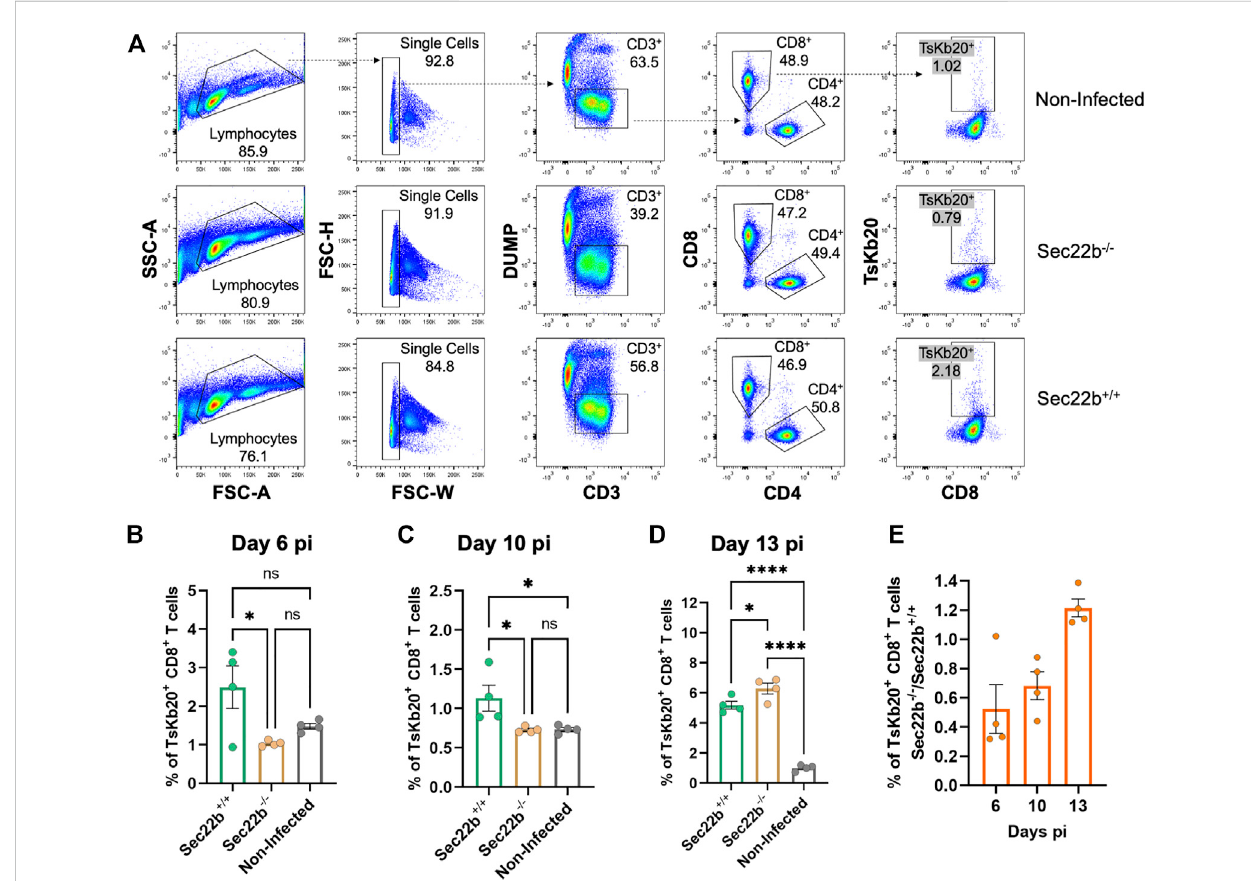
FIGURE 3 Analysis of the speci fi c TsKb20-CD8 + T cells response in lymph nodes. (A) Gating strategy used to analyze cells derived from lymph nodes at day 10pi.Aswithsplenocytes,CD3 + cellswereselected,excludingdeadcells,Blymphocytes,andmyeloidcellswithaDUMPchannel.CD8 + Tcellswerethen determined (as positive cells for the CD8 marker) and TsKb20-CD8 + T cells were determined as the tetramer positive population. Analysis of the speci fi c TsKb20-CD8 + T cells (%) in lymph nodes at day 6 p. i. (B) ( p-values : Sec22b +/+ vs. Sec22b − / − 0.0263, Non-Infected vs. Sec22b +/+ 0.1194, Non- Infected vs. Sec22b − / − 0.6087; day 10 p. i.) (C) ( p-values : Sec22b +/+ vs. Sec22b − / − 0.0377, Non-Infected vs. Sec22b +/+ 0.0399, Non-Infected vs. Sec22b − / − 0.9993) and day 13 p. i. (D) ( p-values : Sec22b +/+ vs. Sec22b − / − 0.0411, Non-Infected vs. Sec22b +/+ < 0.0001, Non-Infected vs. Sec22b − / − < 0.0001). The analysis was performed using One way ANOVA with Tukey ’ s multiple comparison test, N = 4 (E) Ratio of the percentage of speci fi c TsKb20-CD8 + T cells found in Sec22b − / − mice over the percentage of TsKb20-CD8 + T cells obtained in Sec22b +/+ mice. All bar graphs represent the mean with SEM of the parameter analyzed in each